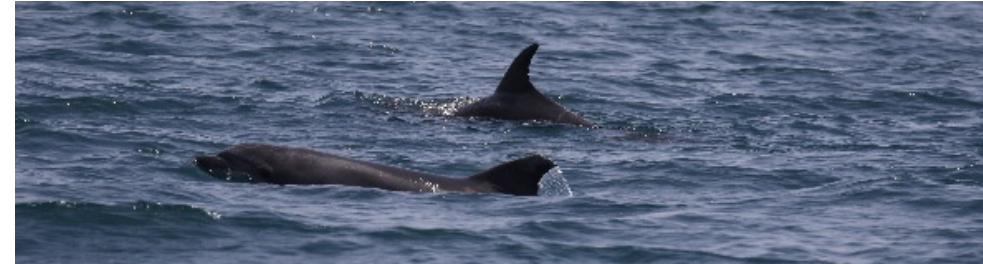
Figure 3. The putative mother (“A”) carrying the dead calf on her rostrum .